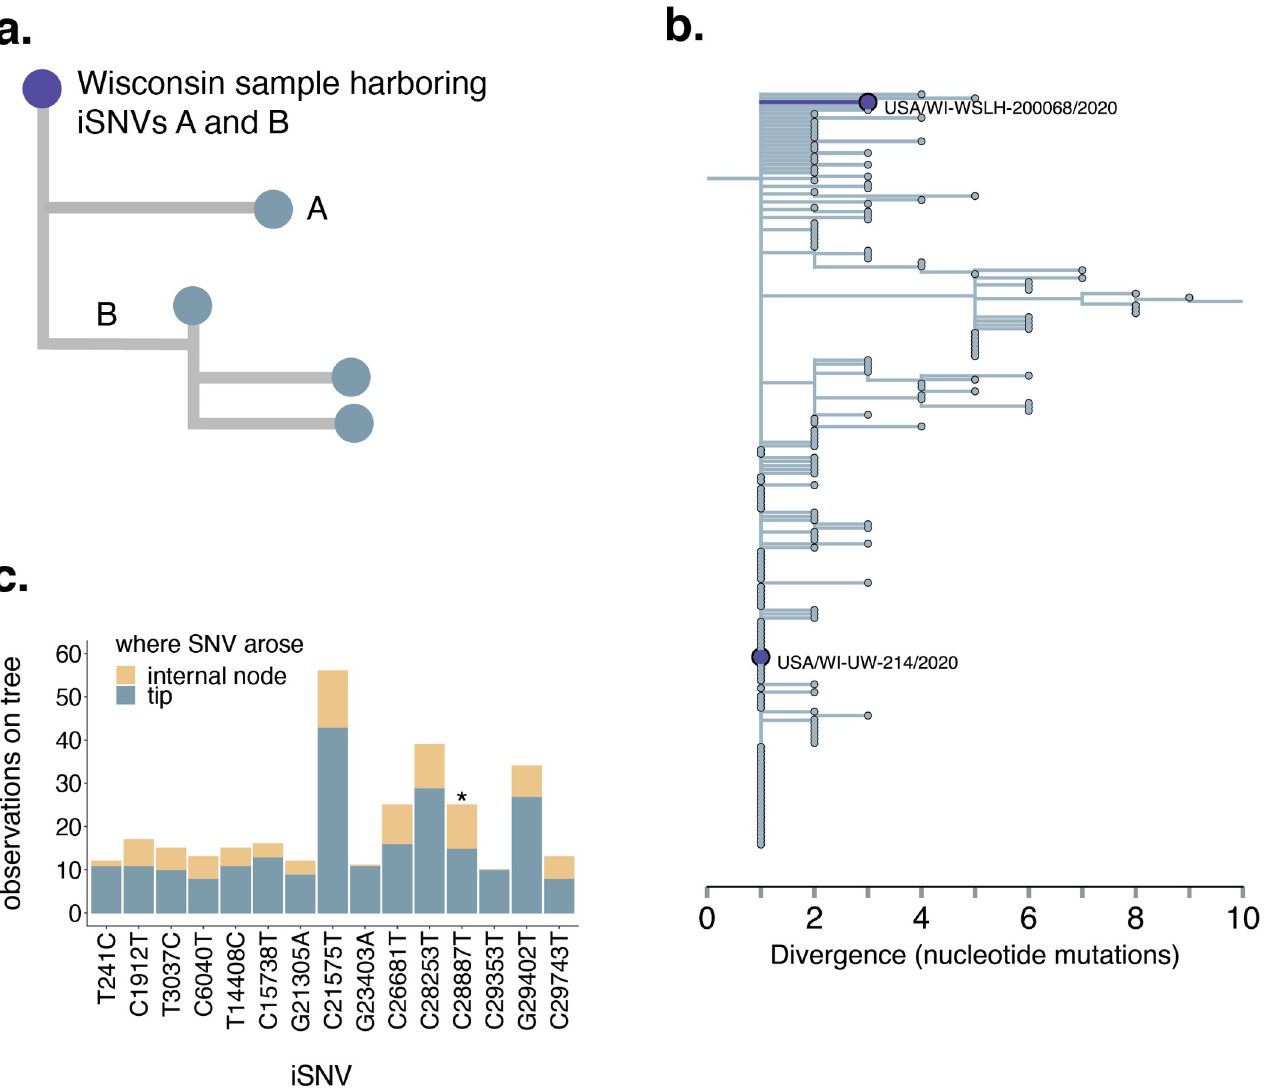
Fig 3. Variants are not common in consensus sequences or in downstream branches. a. We traversed the Wisconsin-focused full-genome SARS-CoV-2 phylogeny from root to tip. For each Wisconsin tip for which we had within-host data, we queried whether any of the iSNVs detected in that sample were ever detected in downstream branches at consensus. In this example, the purple tip represents a Wisconsin sample for which we have within-host data. This sample harbors 2 iSNVs, A and B. iSNV A arises on a tip that falls downstream from the starting, purple tip. iSNV B is present on a downstream branch leading to an internal node. Both A and B would be counted as instances in which an iSNV was detected at consensus in a downstream branch. b. In the Wisconsin-specific phylogenetic tree, we applied the metric described in a. Among 110 Wisconsin samples that harbored within-host variation, 93 occurred on internal nodes. Of those, we detect one instance in which a mutation detected as an iSNV in one sequence was detected in a downstream consensus sequence. (C1912T, an iSNV in USA/WI-UW-214/2020, was detected downstream in USA/WI-WSLH-200068/2020.) c. For each iSNV identified in the study (in at least 1 sample), we enumerated the number of times that variant occurred on the global SARS-CoV-2 phylogeny on an internal node (yellow) or on a tip (blue). The results for every variant are shown in S6 Fig . Here, we show only the variants that were detected at least 10 times on the global phylogeny. Each such iSNV is found at internal nodes and tips at a ratio comparable to overall mutations on the tree, except for C28887T, which is enriched on internal nodes (p = 0.028, Fishers’ exact test). � indicates p-value <